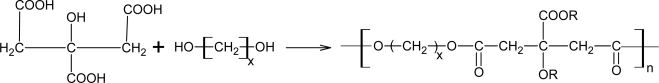
Synthesis of poly(diol citrates) [21].